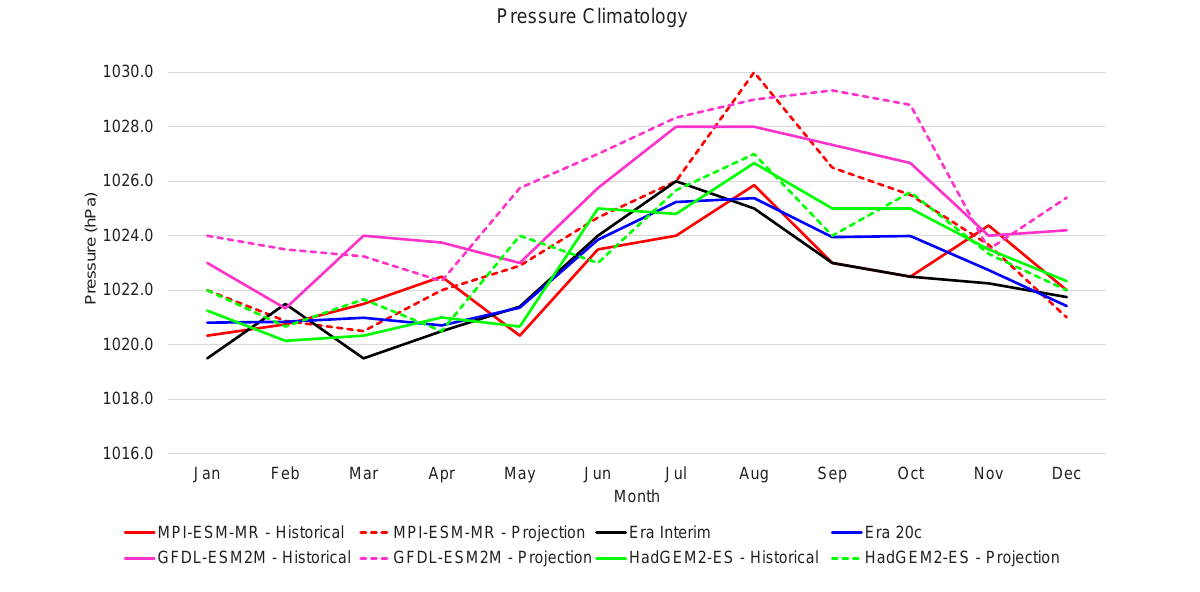
FIGURE 4 | Monthly climatology of the pressure (hPa) of the SASA